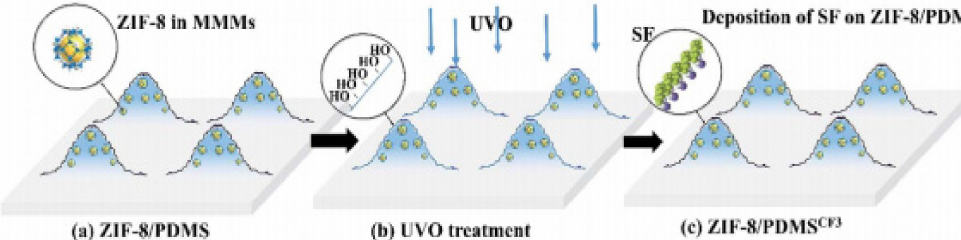
Figure 5. Synthesis of SAMs-modified ZIF-8/PDMS superhydrophobic membrane [34]—(Republished with permission of Royal Society of Chemistry, from “Designing superhydrophobic surfaces with SAM modification on hierarchical ZIF- 8/polymer hybrid membranes for efficient bioalcohol pervaporation”, J. Li, N. Wang, H. Yan, S. Ji, and G. Zhang, vol. 4, no. 104, Copyright (2021); permission conveyed through Copyright Clearance Center,